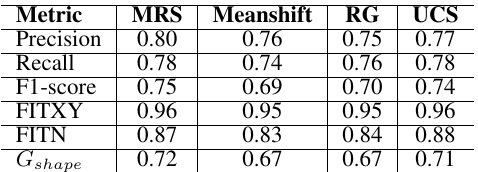
Figure 3. From left to right: Original image with reference polygon in red, MRS segmentation, Mean-shift segmentation, Region Growing segmentation and UCS segmentation